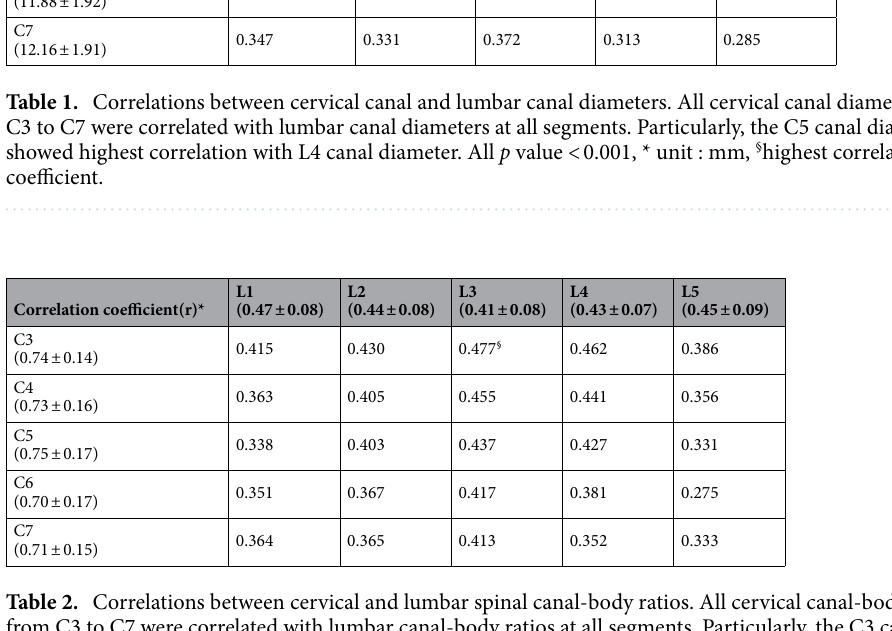
Inter- and intra-observer reproducibilities were high for vertebral body and canal diameter measurement. Inter- observer ICCs for vertebral body and canal diameter measurement were 0.821 and 0.879, respectively, and the corresponding intra-observer ICCs were 0.912 and 0.920, respectively. The mean measurements of the sagittal diameter of the vertebral body (C3-C7) were 16.6 ± 1.8 mm (C3), 16.5 ± 2.0 mm (C4), 16.5 ± 2.4 mm (C5), 17.4 ± 2.3 mm (C6), and 17.4 ± 2.2 mm (C7). The mean measurements of cervical canal diameter (C3-C7) were 12.1 ± 1.5 mm (C3), 11.9 ± 1.7 mm (C4), 12.1 ± 1.9 mm (C5), 11.9 ± 1.9 mm (C6), and 12.2 ± 1.9 mm (C7). The cervical 6 th and 7 th vertebral body diameters are significantly larger than the dimeters of C3-C5 vertebral body ( p < 0.001), but cervical canal diameters are similar in all cervical segments (C3-C7). The mean measurements of sagittal diameter of the vertebral body (L1-L5) were 30.0 ± 2.9 mm (L1), 31.6 ± 3.0 mm (L2), 33.1 ± 3.0 mm (L3), 33.4 ± 2.9 mm (L4), and 33.1 ± 3.1 mm (L5). The mean measurements of lumbar canal diameters (L1-L5) were 14.1 ± 1.7 mm (L1), 13.8 ± 1.6 mm (L2), 13.4 ± 1.8 mm (L3), 14.1 ± 1.9 mm (L4), and 14.6 ± 2.4 mm (L5). Similar to the cervical vertebrae, lumbar vertebral body diameters are significantly larger in L3-L5 than those of L1-L2 ( p < 0.001), but lumbar canal diameters are similar in L1-L5 vertebrae. The cervical canal diameters (C3-C7) were significantly correlated with lumbar canal diameters at all segments (L1-L5) ( p < 0.001). The C5 cervical canal diameter showed the highest significant correlation with the L4 canal diameter (r = 0.435, p < 0.001) (Table 1). Meanwhile, the mean canal-body ratios of the cervical spine (C3-C7) were 0.74 ± 0.14 (C3), 0.73 ± 0.16 (C4), 0.75 ± 0.17 (C5), 0.70 ± 0.17 (C6), and 0.71 ± 0.15 (C7). The mean lumbar canal-body ratios (L1-L5) were 0.47 ± 0.08 (L1), 0.44 ± 0.08 (L2), 0.41 ± 0.08 (L3), 0.43 ± 0.07 (L4), and 0.45 ± 0.09 (L5). The cervical canal-body ratios of cervical spine (C3-C7) were also significantly correlated with those of lumbar spine at all segments (L1-L5) ( p < 0.001). The canal-body ratios of the C3 (0.74 ± 0.14) were most significantly correlated with those of the L3 (0.41 ± 0.08) (r = 0.477, p < 0.001) (Table 2). In comparisons between male and female patients, the C5 and L4 canal diameters were not significantly different ( p > 0.05), but male patients showed significantly lower mean canal-body ratios than female patients (C3:0.72 vs. 0.76, p = 0.038 and L3: 0.39 vs. 0.44, p < 0.001) (Fig. 2). Uniquely, the patient’s age was inversely cor- related with the C5 canal diameter (r = − 0.201, p = 0.002) and the C3 canal-body ratio (r = − 0.243, p < 0.001), but did not show a significant relationship with the L4 canal diameter or the canal-body ratio of the L3 (Table 3). The spinal canal stenosis is more remarkable in male and elderly patients than in female and young patients.